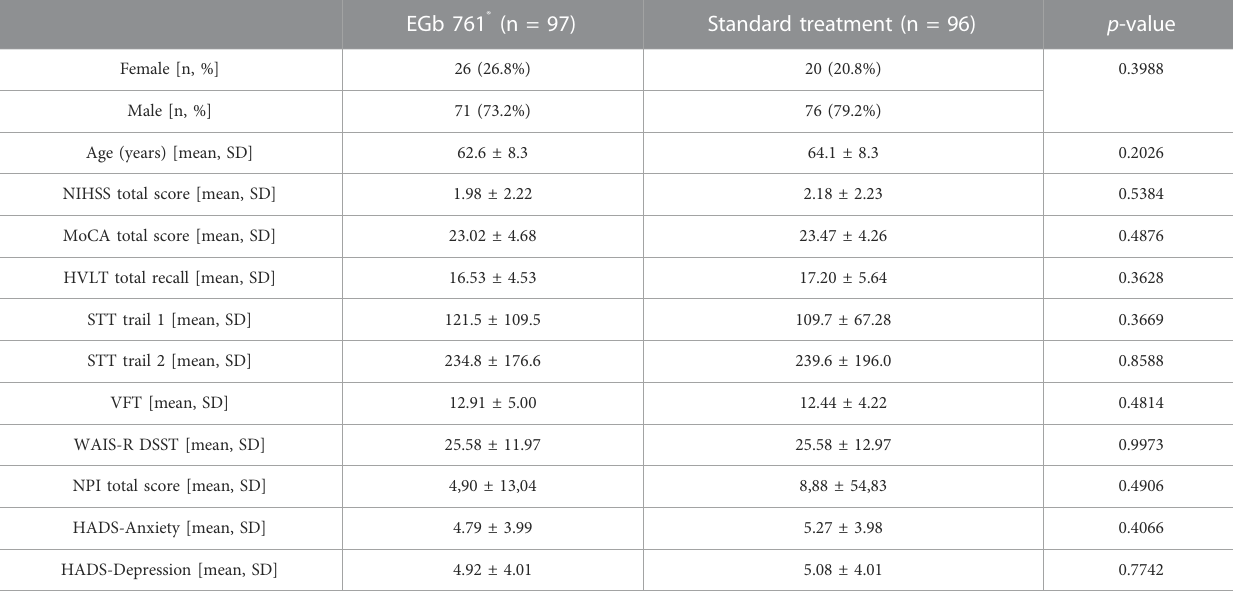
Abbreviations:NIHSS,nationalinstitutesofhealthstrokescale;MoCA,montrealcognitiveassessment;HVLT,hopkinsverballearningtest;STT,shapetrailtest;VFT,verbal fl uencytest;WAIS- R, Wechsler Adult Intelligence Scale-Revised; DSST, digit symbol substitution test; NPI, neuropsychiatric inventory; HADS, hospital anxiety and depression scale; SD, standard deviation.